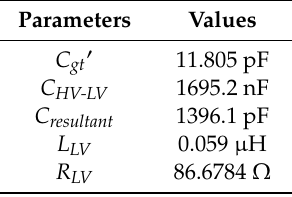
Table 10. Modified RLC parameters of LV winding with shield placement between HV and LV